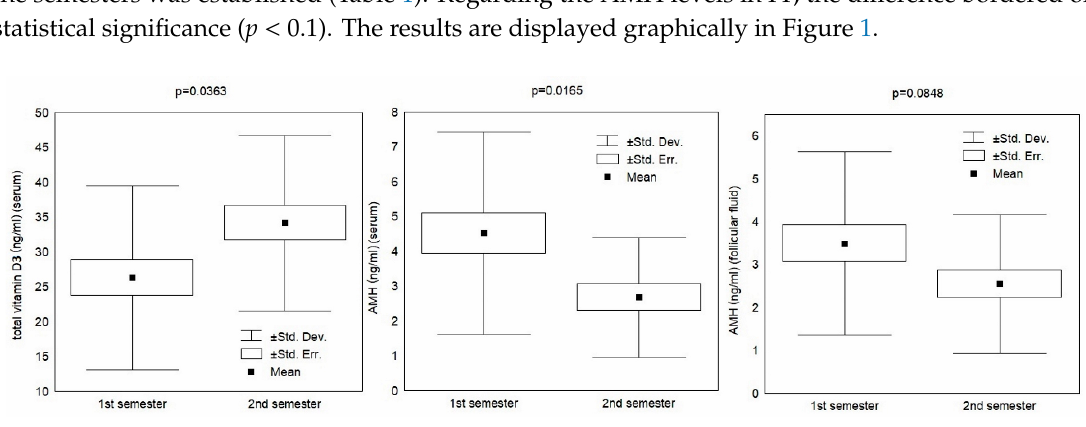
Figure 1. Total vitamin D and anti-Müllerian hormone (AMH) by semester.